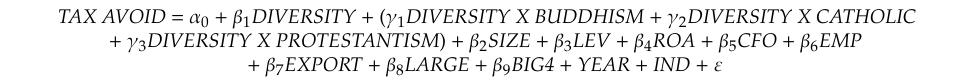
Table 4. The e ff ects of directors’ religious diversity and CEOs’ religion on tax avoidance of